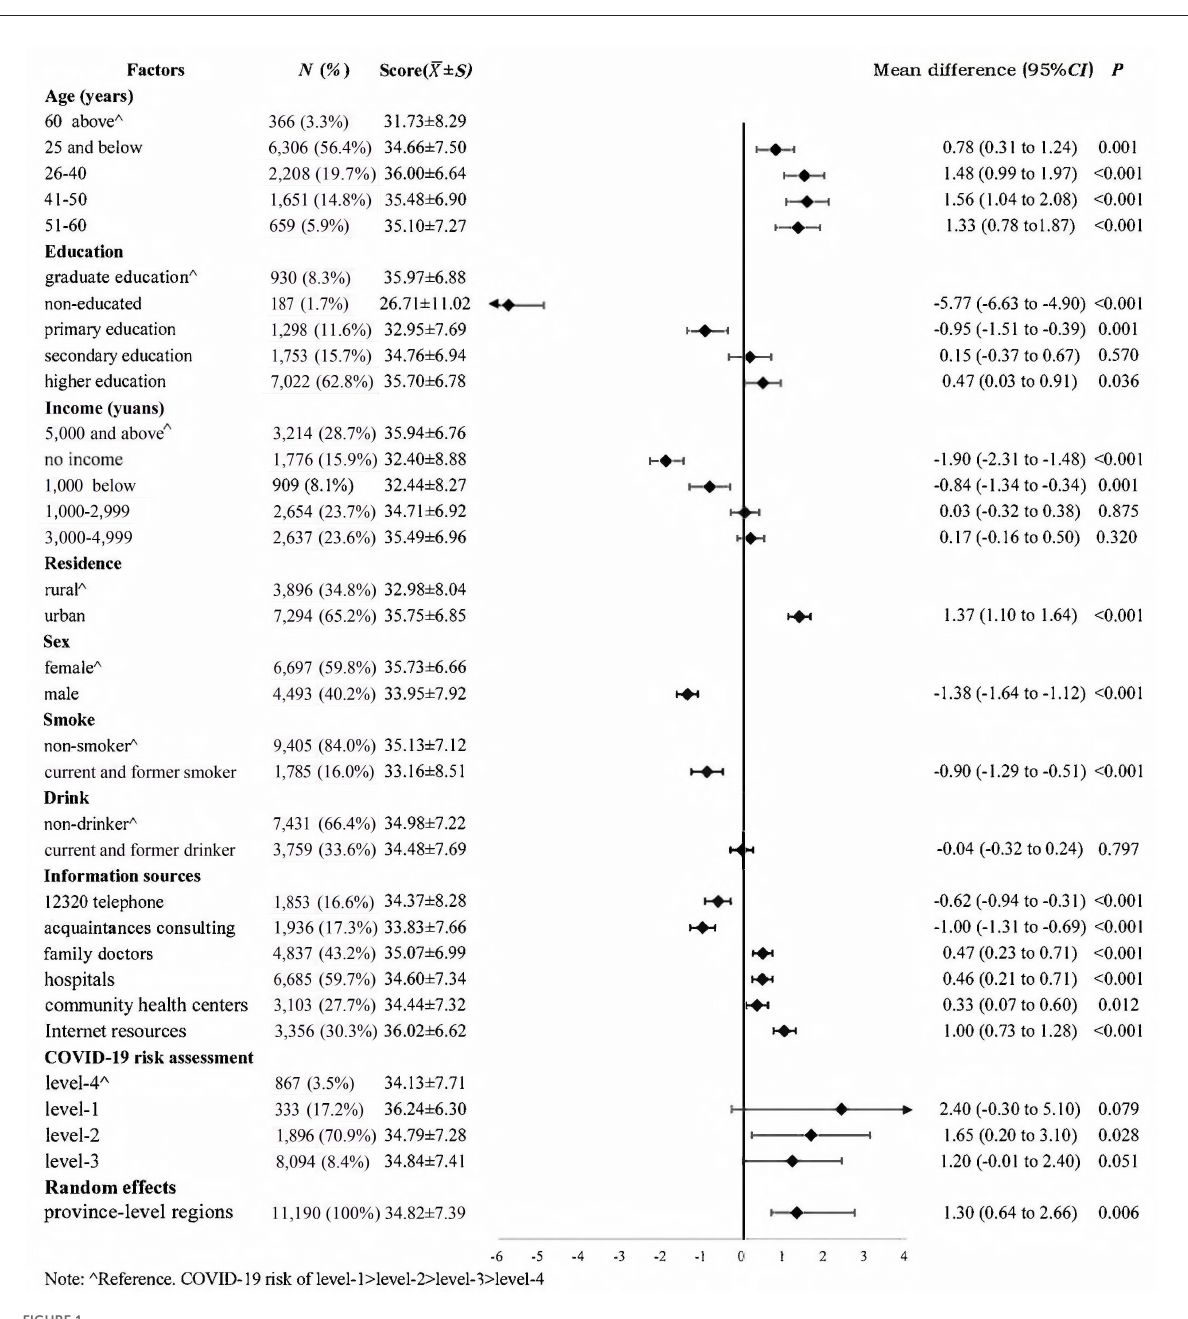
FIGURE1 Risk factors for COVID-19 preventive